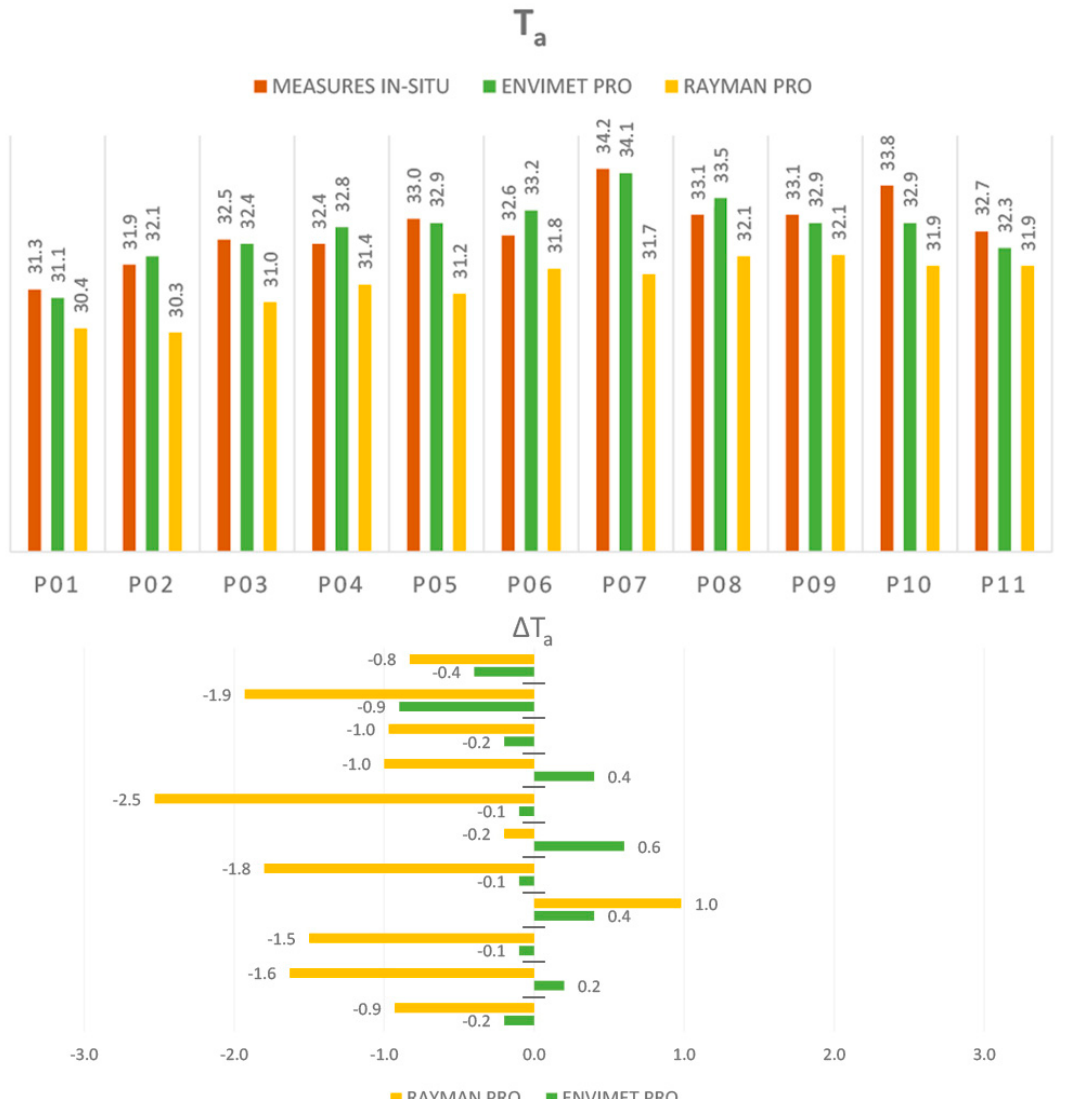
Figure 3. A comparison of the temperature value between the simulation results and the in-situ measurements, z = 1.80 m.